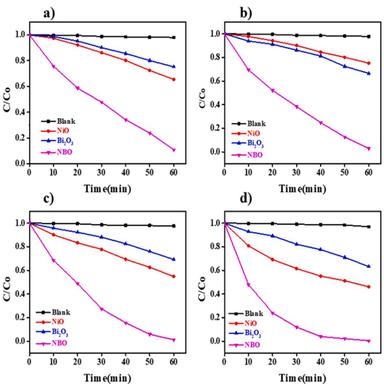
Photodegradation of MB dye a) 20 ppm, b) 15 ppm, c) 10 ppm, d) 5 ppm blank and presence of pure NiO, Bi2O3 and NBO.